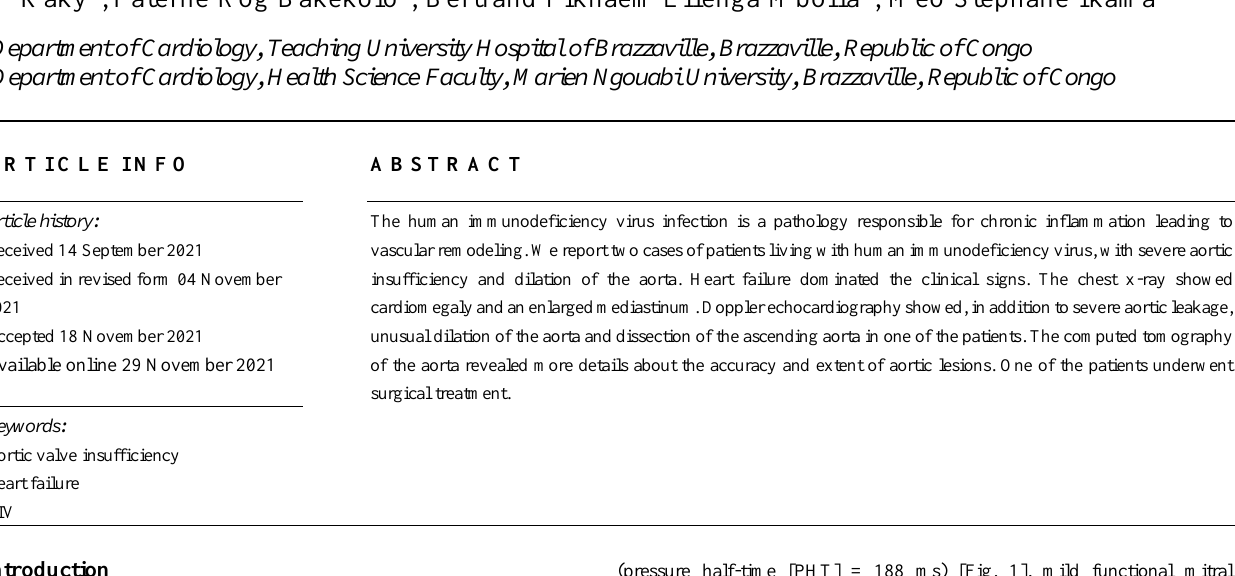
(pressure half-time [PHT] = 188 ms) [Fig. 1], mild functional mitral insufficiency and dilation of the ascending aorta.